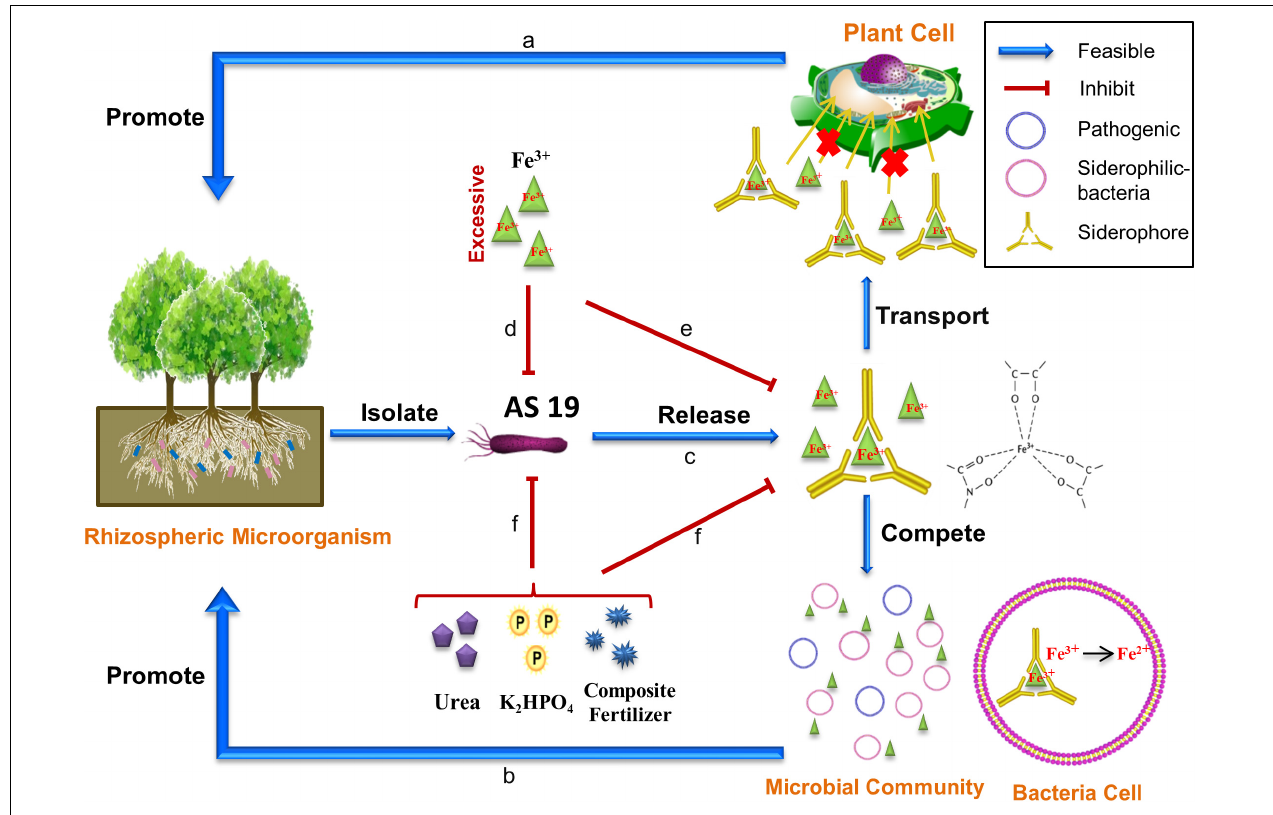
FIGURE 9 | Schematic of the possible plant growth promoting pathway by AS19. (a) Fe 3 + cannot enter plant cells directly, but the complex is transported across the membrane into the plant to help it absorb nutrients. (b) Siderophores alter the microbial community. Pathogenic microbes do not grow due to a lack of bioavailable iron. (c) AS19 secretes siderophores. (d) In LB medium with 0.3% agar, the addition of iron had no effect on the growth of AS19, but a low concentration of Fe 3 + promoted motility, and excessive Fe 3 + inhibited motility. (e) In a low-iron environment, excessive Fe 3 + significantly inhibited the growth of AS19 and the production of siderophores. (f) In a low-iron environment, chemical fertilizer inhibited the growth of AS19 and the secretion of siderophores to varying degrees. Interestingly, the addition of low-dose compound fertilizer slightly increased the bacterial growth but still inhibited the siderophore